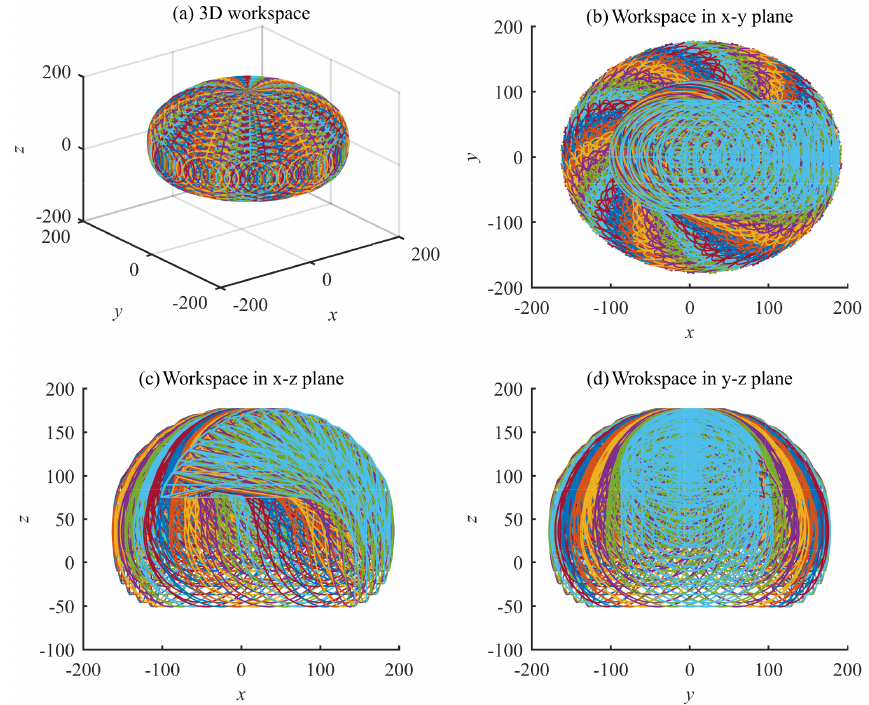
Figure 7. Workspace of the bio-inspired robotic arm.